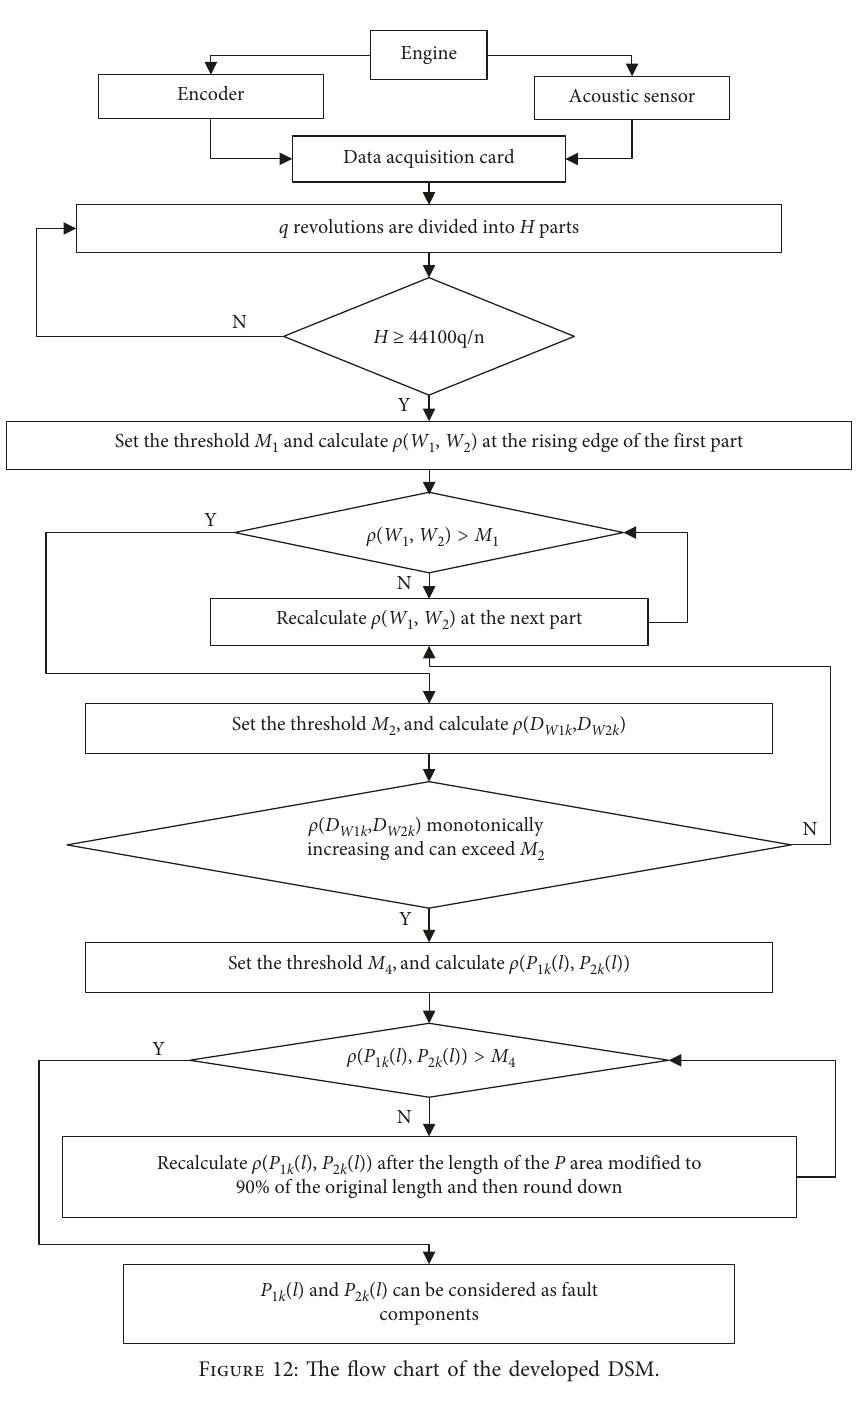
Figure 12: The flow chart of the developed